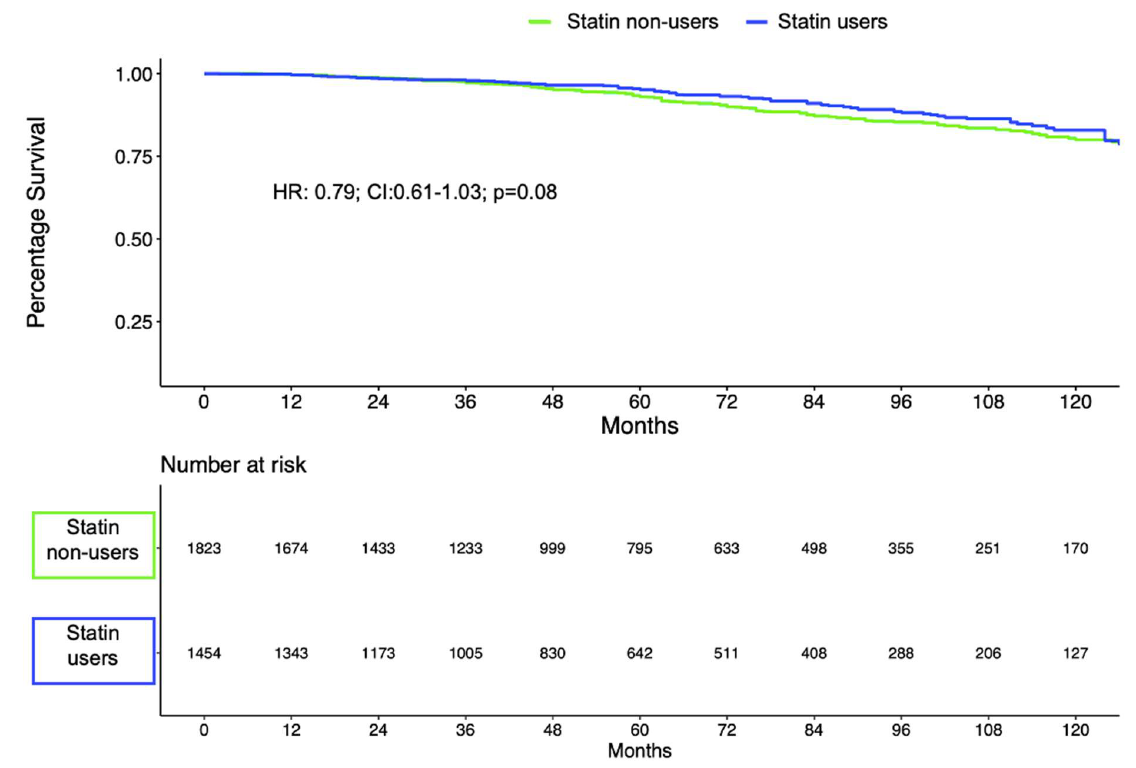
Figure 1. BCR-free survival estimated by Kaplan–Meier and stratified by statin intake. Table 2. Univariable and multivariable Cox regression models predicting biochemical recurrence within the overall study population, stratified according to statin use.